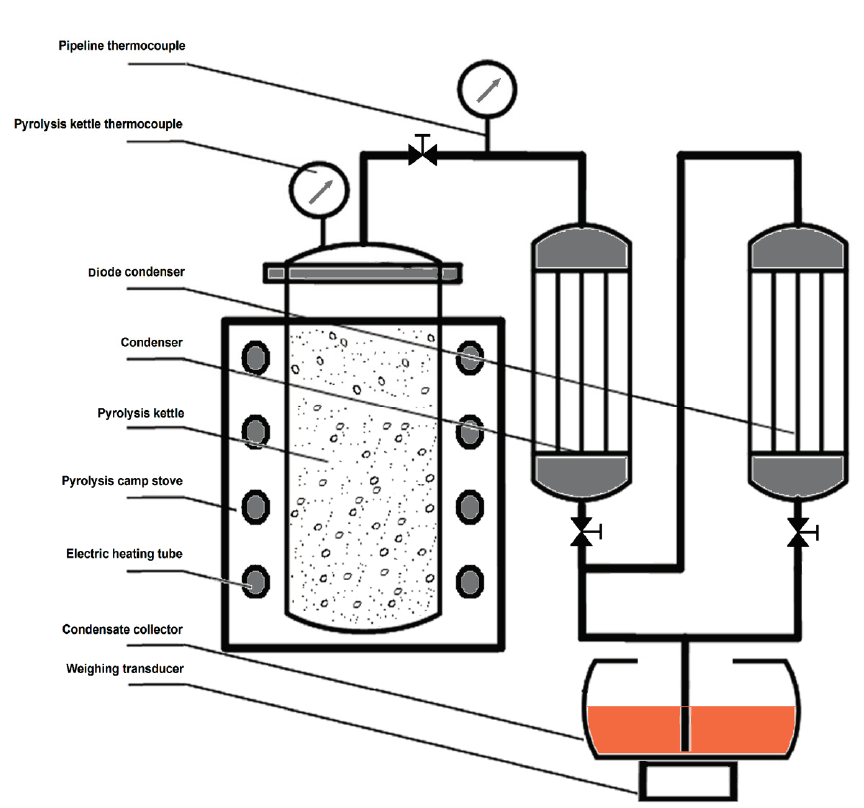
Figure 7. Schematic diagram of the pyrolysis